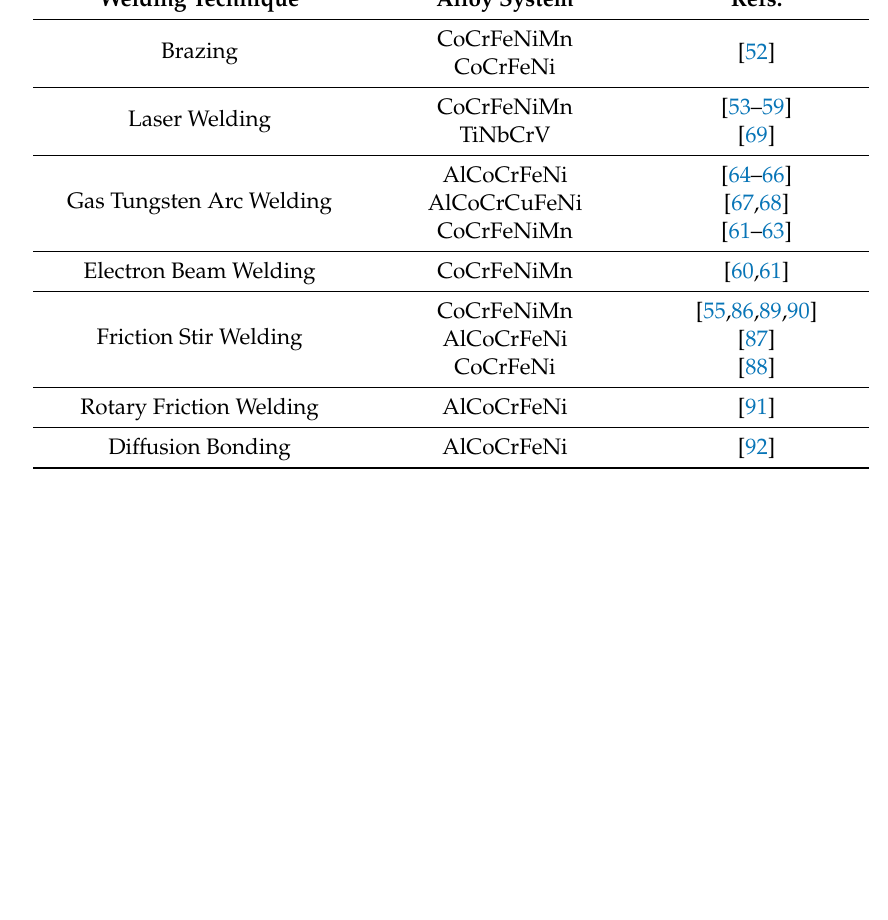
Table 2. Summary of the welding techniques currently used on